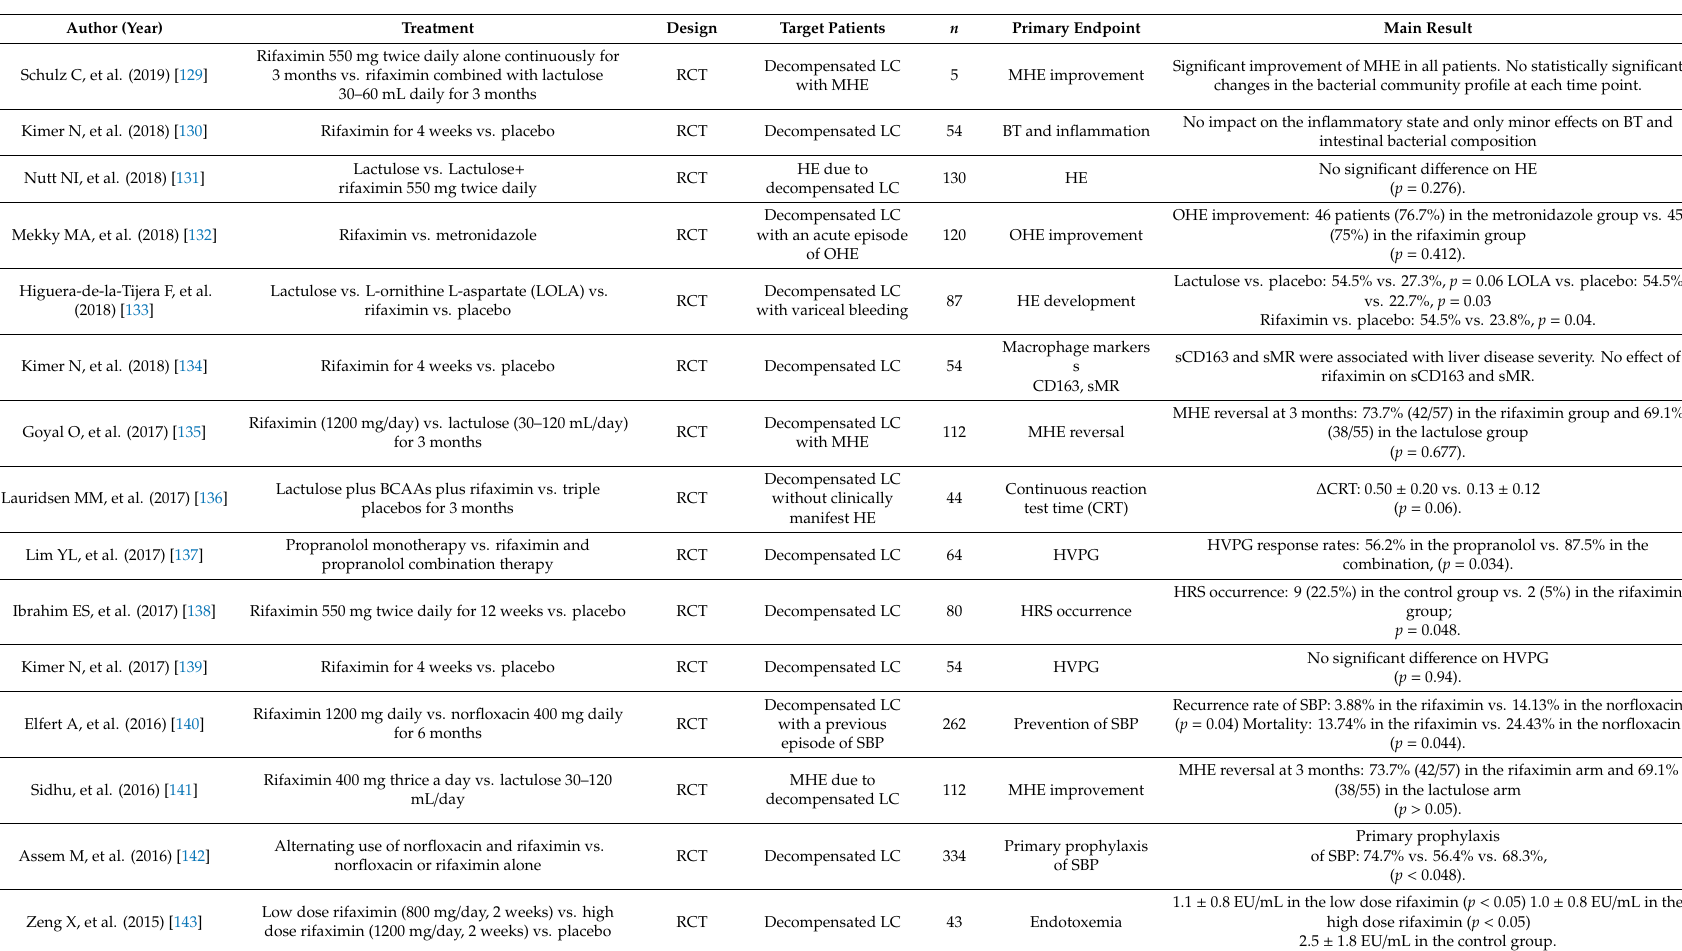
Table 2. Randomized controlled trials published since 2010 regarding the e ff ect of rifaximin in patients with decompensated liver cirrhosis. MHE: minimal hepatic encephalopathy; BT: bacterial translocation; OHE: overt hepatic encephalopathy; sMR: soluble mannose receptor; HRS: hepatorenal